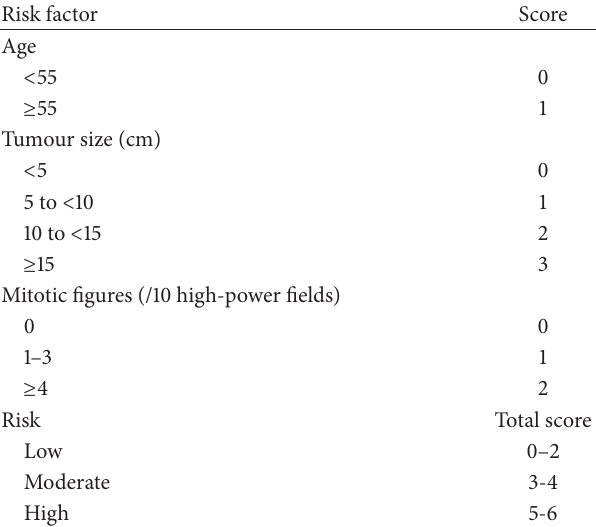
Table 1: Risk stratification model